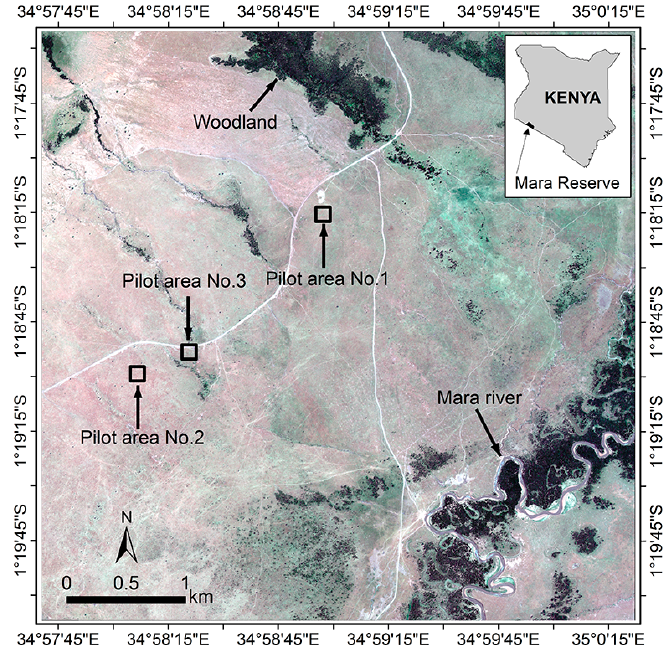
Figure 1. Location of the Maasai Mara National Reserve in Kenya and the three pilot study areas on a natural color composite of a GeoEye-1 image, acquired on 11 August 2009.